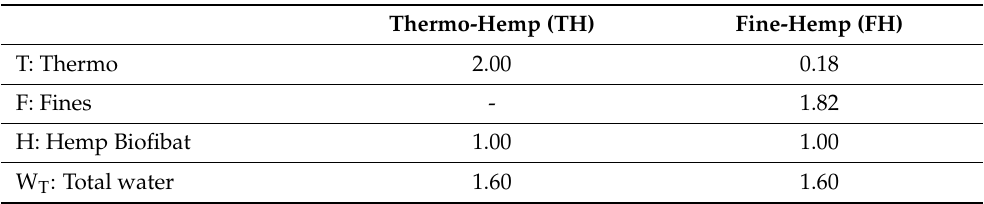
Table 4. Formulation of thermo-hemp (TH) and fine-hemp (FH) composites in mass portions with reference to the mass of hemp.